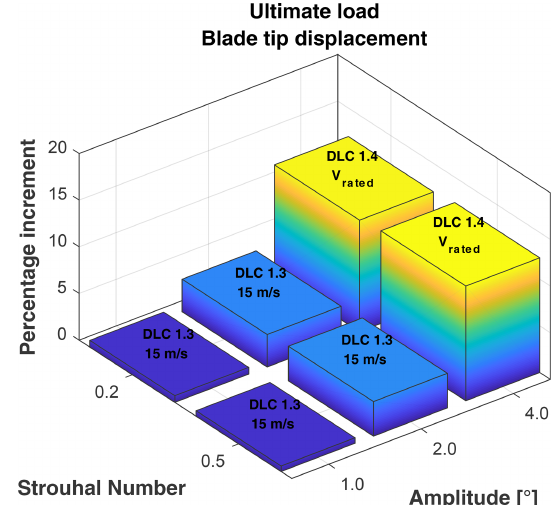
Figure 7. Blade tip maximum displacement increase as a function of amplitude and Strouhal